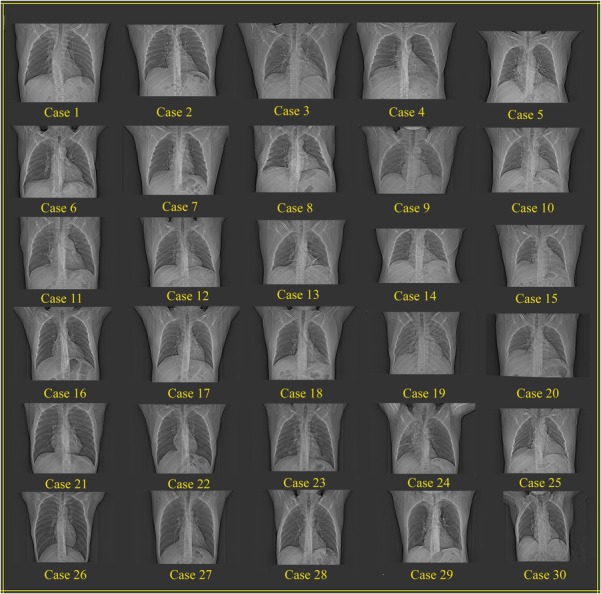
Comparison of the lung size of 30 normal patients in radiography images. The cases that have been placed in a particular row belong to the same height/weight percentile. The variation in lung volume for the patients in any given row is clear.